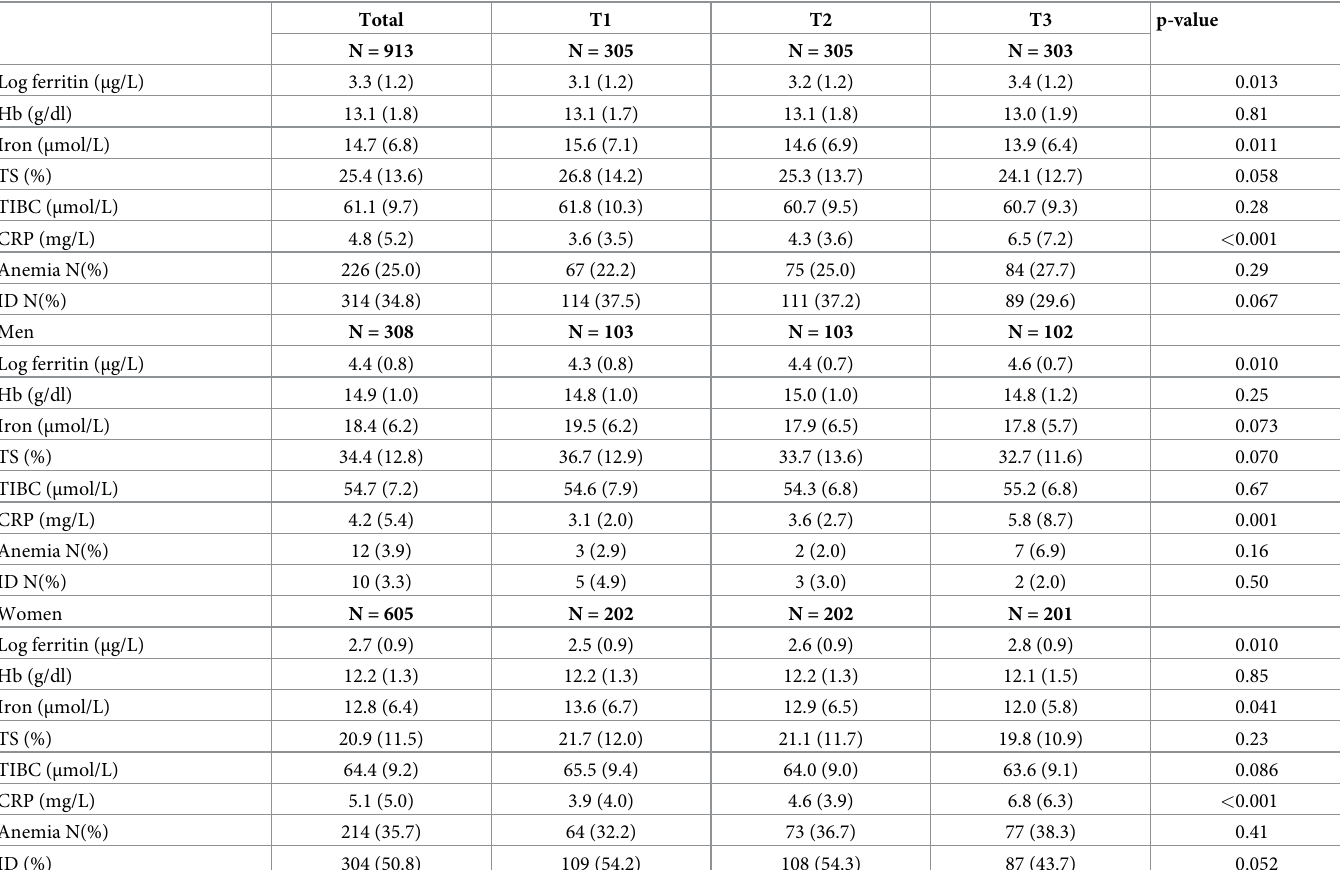
Table 4. Comparison of iron status indicators according to VF